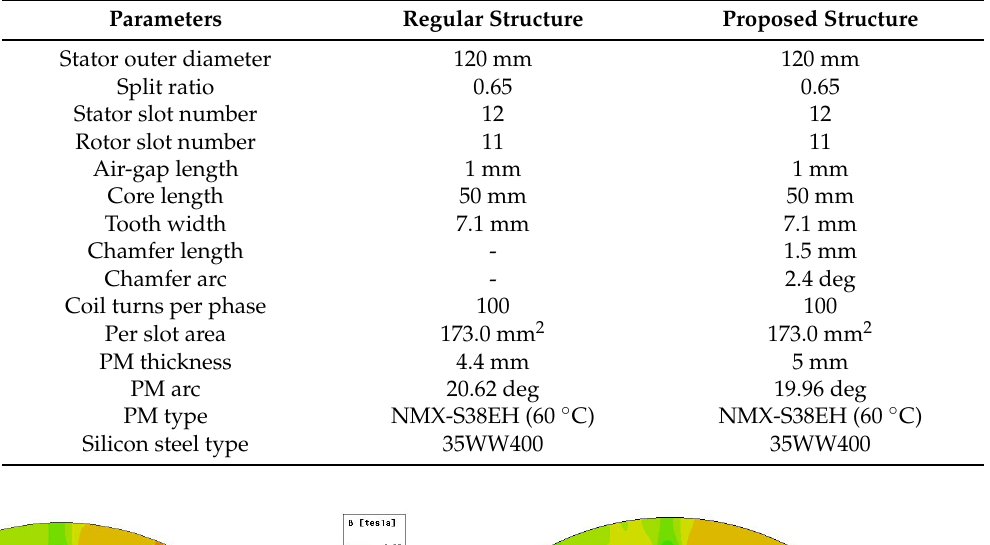
Table 2. Design parameters of both machines.